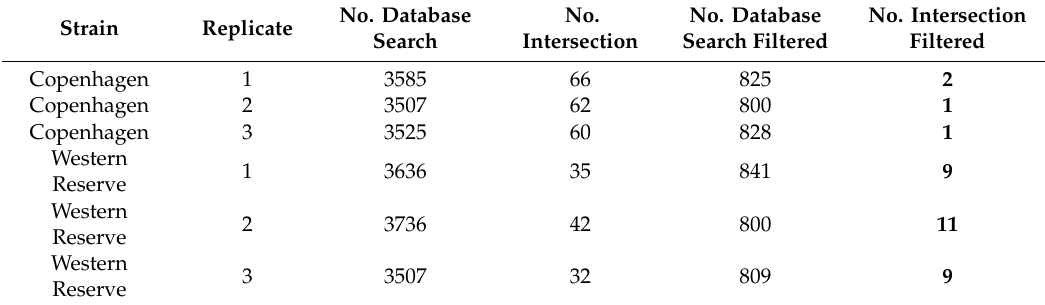
Table 7. This table shows the number of peptides from VACV Copenhagen and VACV Western Reserve strain after (i) database search with duplicates removed; (ii) intersection of peptides obtained by Purple and database search; (iii) database search, duplicates removed and filtering by FDR; and (iv) intersection of peptides obtained by Purple and filtered database search. Each target strain was compared against the background of the other strain and all reviewed virus proteomes. The second column specifies the replicate data that was used for the database search.